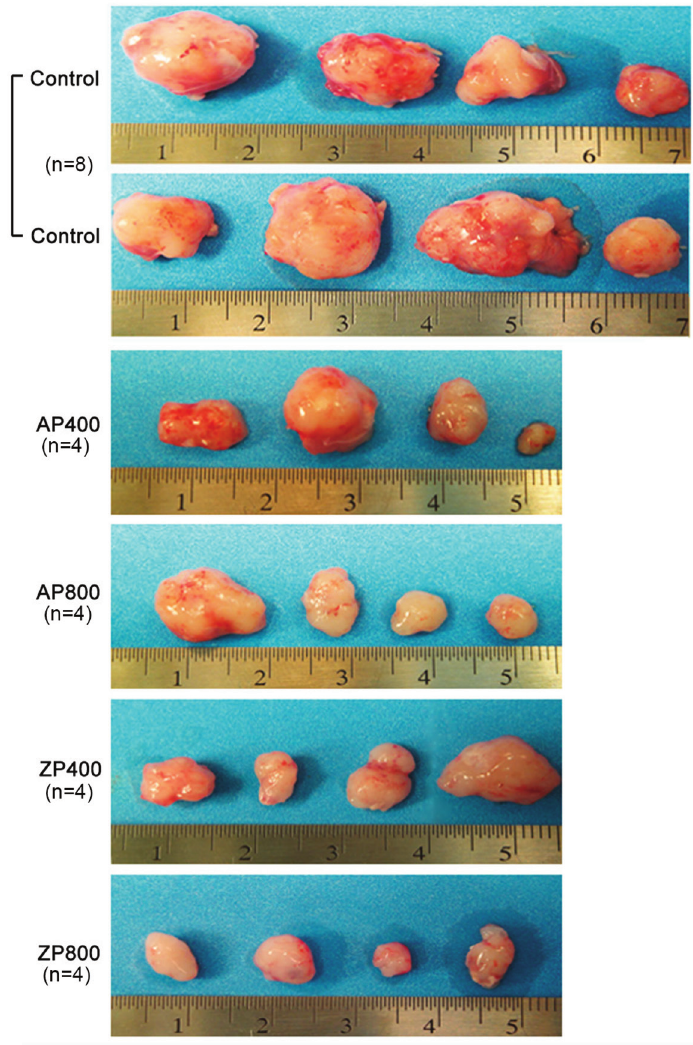
Fig 6. Nisin ZP reduces HNSCC tumor burden in mice. Images show the dissected tumors obtained from mice injected with UM-SCC-17B cells then treated with either water (control) or nisin AP or nisin ZP (400 or 800 mg/kg body weight/day) for 3